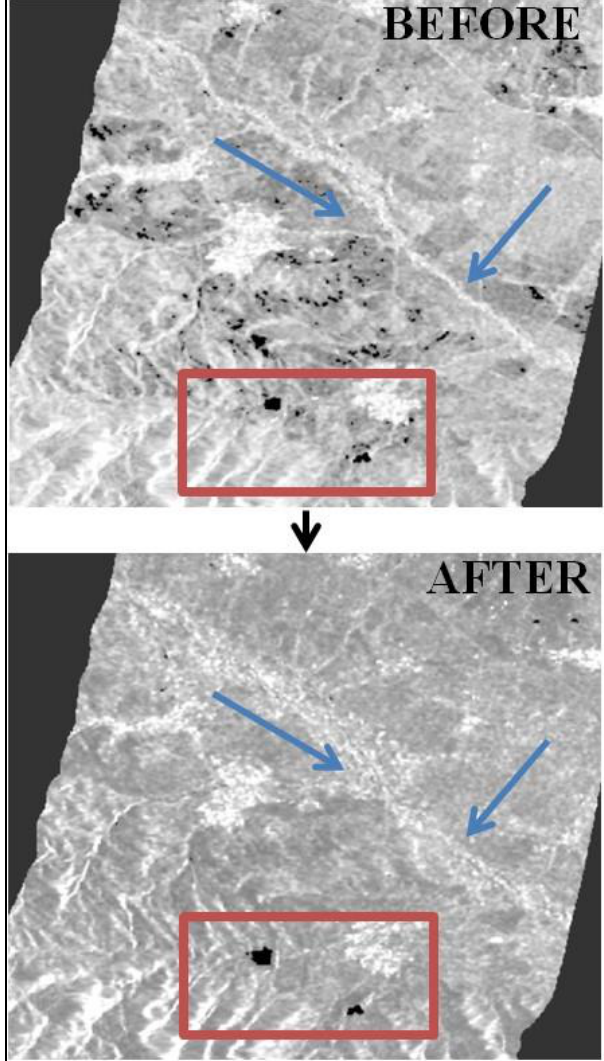
Figure 5. Results of radar data processing. Affected area before the flood ( top ), affected area after the flood ( bottom